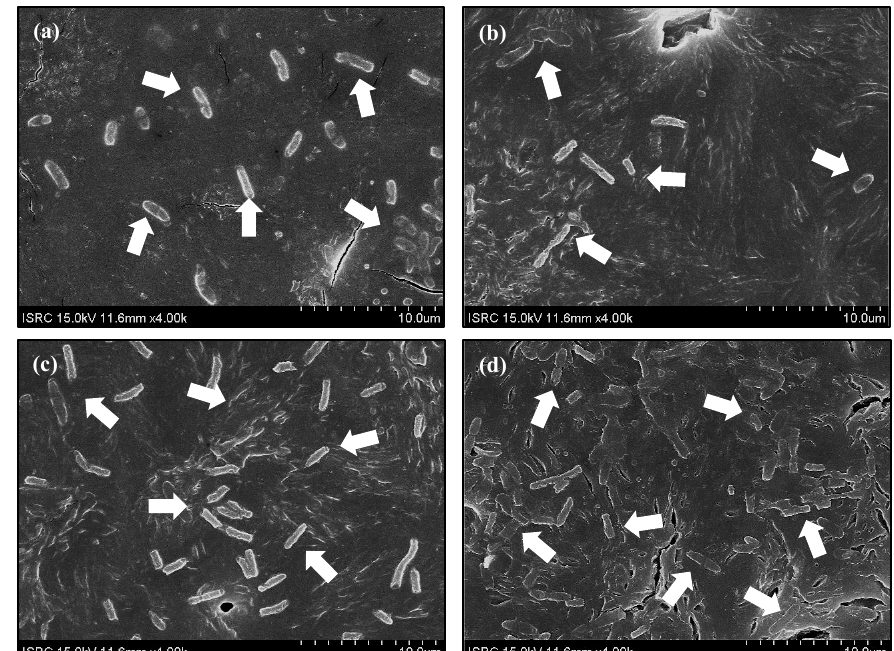
Figure 4. SEM images of bacterial attachment on PCL microstructure